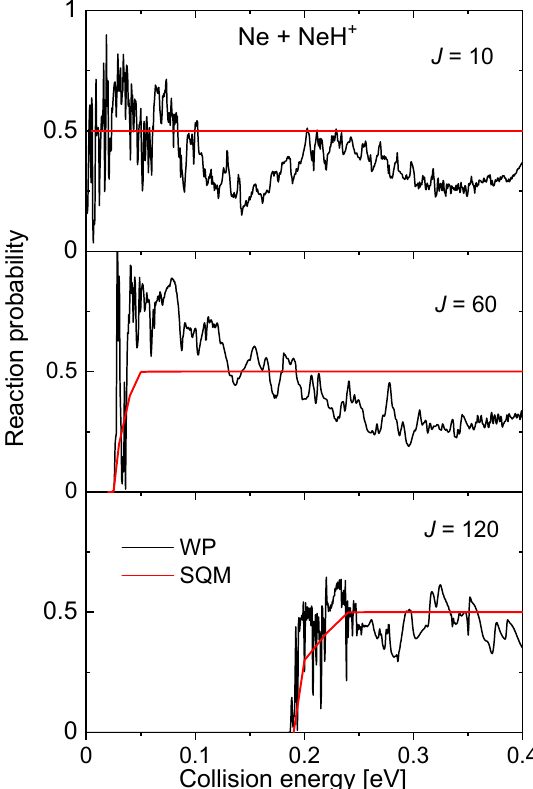
Figure 14. Reaction probability calculated as a function of the collision energy (in eV) for the Ne + NeH + → Ne + NeH + reaction for three different values of the total angular momentum J = 10 ( top panel ), J = 60 ( middle panel ) and J = 120 (red) obtained with the WP (red lines) and SQM (black lines) from Reference [70].